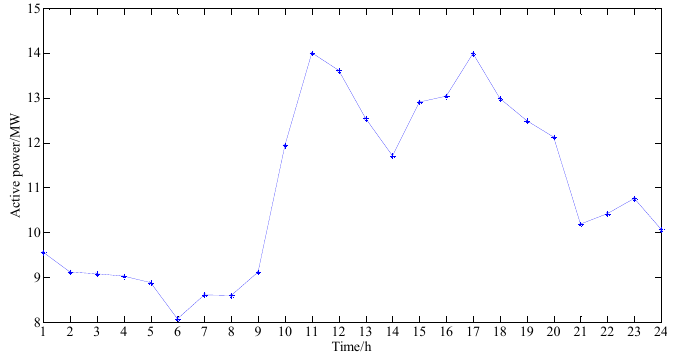
Figure 6. The load curve of the next day.